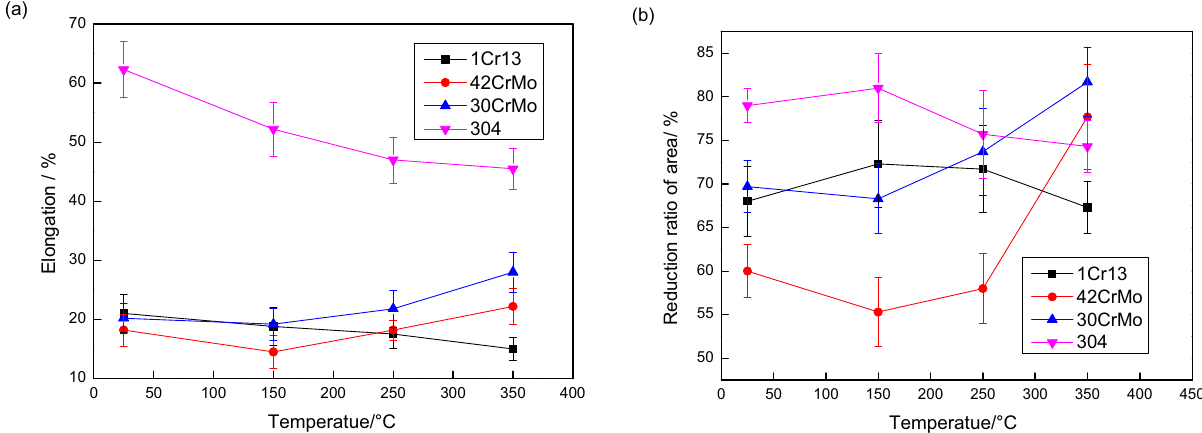
Figure 4: Elongation and reduction ratio of area curves of 30CrMo, 42CrMo, 1Cr13, and stainless steel 304 at 25, 150, 250, and 350°C: ( a ) elongation and ( b ) reduction ratio of area.